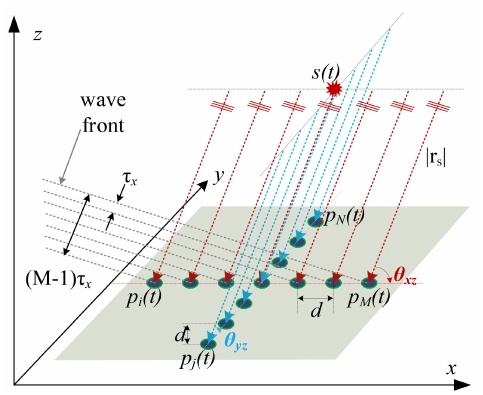
Figure 1. Planar wavefront model on a uniformly arranged microphone array in the x - y